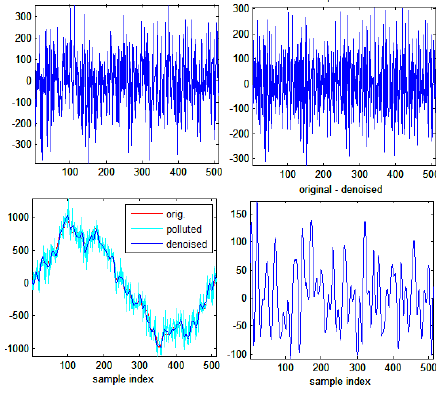
Figure 7. Results yielded by the WPT based de- noising algorithm, for minimum noise, 1-st set.